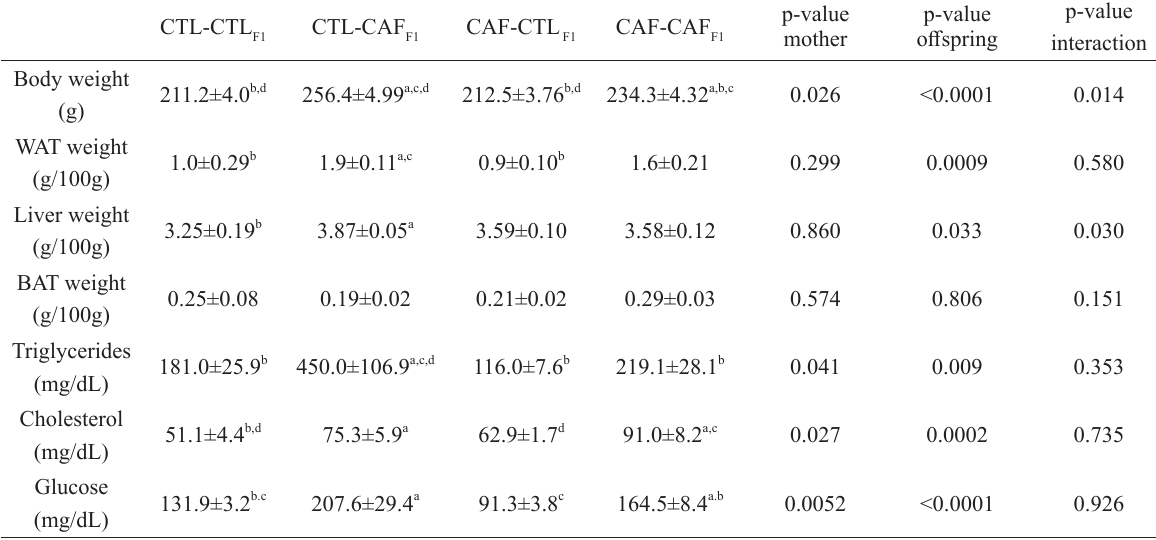
Data are mean ± standard error mean (SEM) showing comparison between the different groups. a comparison with group CTL- CTL , control offspring born from dams that were fed on control diet; b CTL-CAF F1 fed on control diet; c CAF-CTL , control offspring born from dams that were fed on a cafeteria diet; d CAF-CAF F1 offspring born from dams that were fed on a cafeteria diet; p-values (p<0.05) by ANOVA followed by Post Hoc Tuckey´s test. The number of animals analyzed was 5-7 rats per group from five different